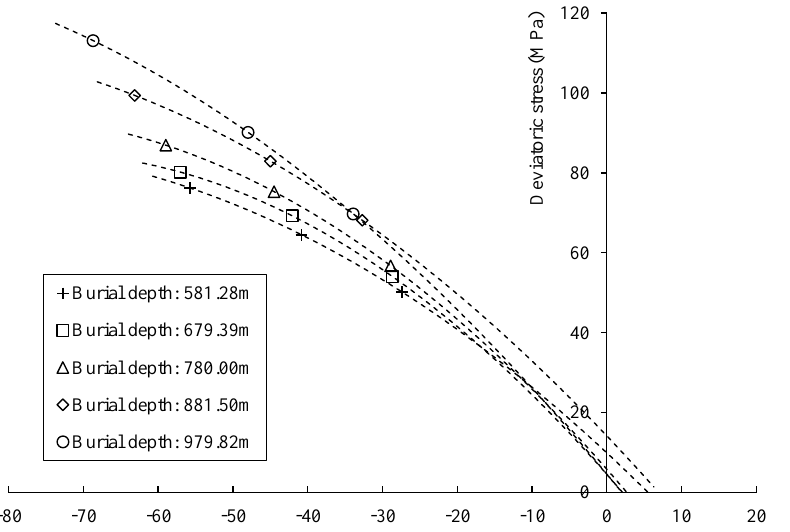
Figure 8. Ultimate yield states of different burial depths clastic sandstones described by mean stress and deviator stress.